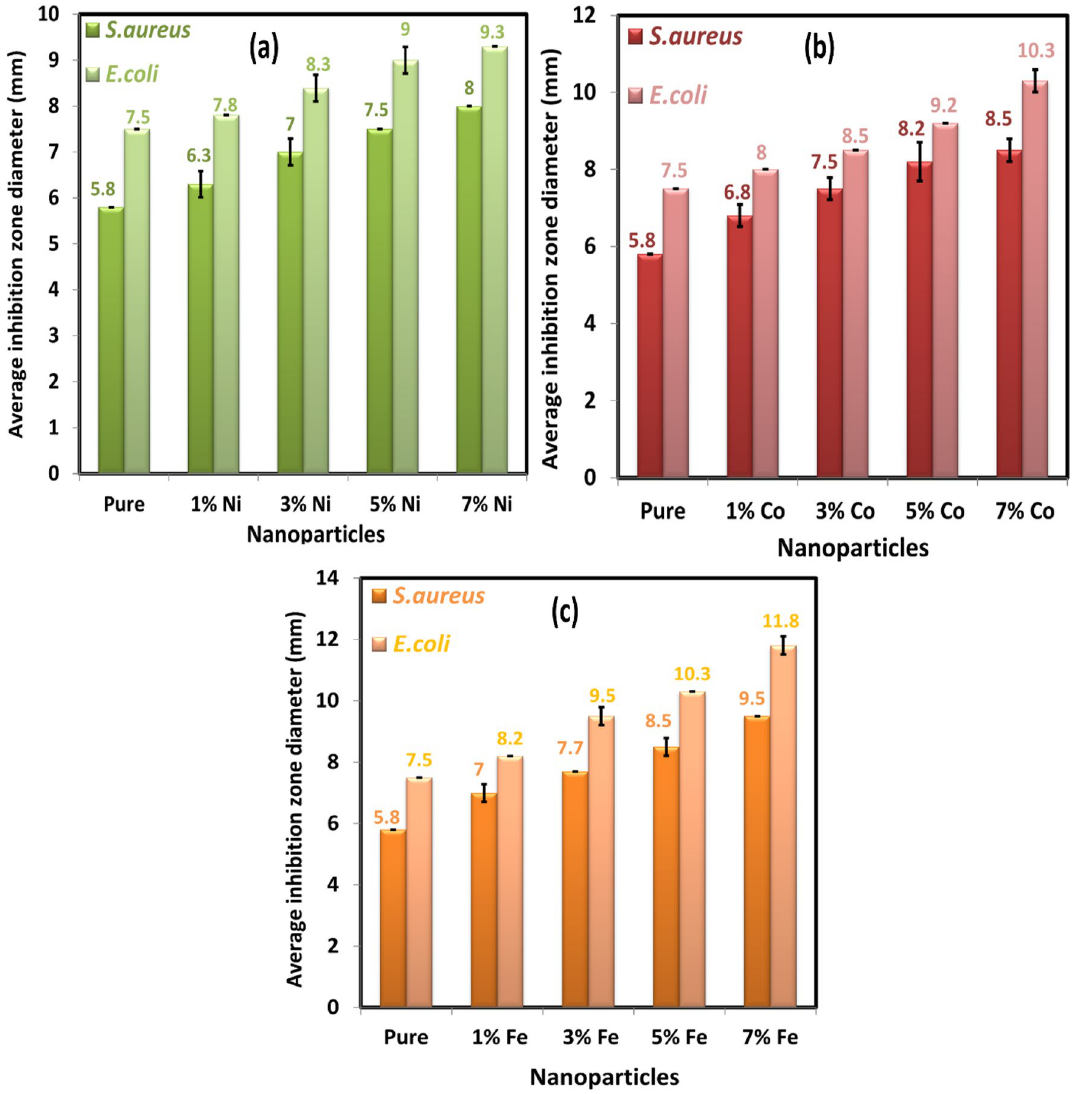
Figure 17. The average diameters of inhibition zone at 40 μg/ml of ( a ) Ni-doped MgO, ( b ) Co-doped MgO and ( c ) Fe-doped MgO nanoparticles with the various doping concentrations of 0%, 1%, 3%, 5%, and